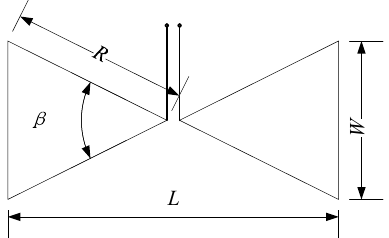
Figure 4. This is typical Bow-tie antenna geometry, the wideband of antenna depends on the cone angle β of triangle fins and the working frequency of antenna depends on its length L .